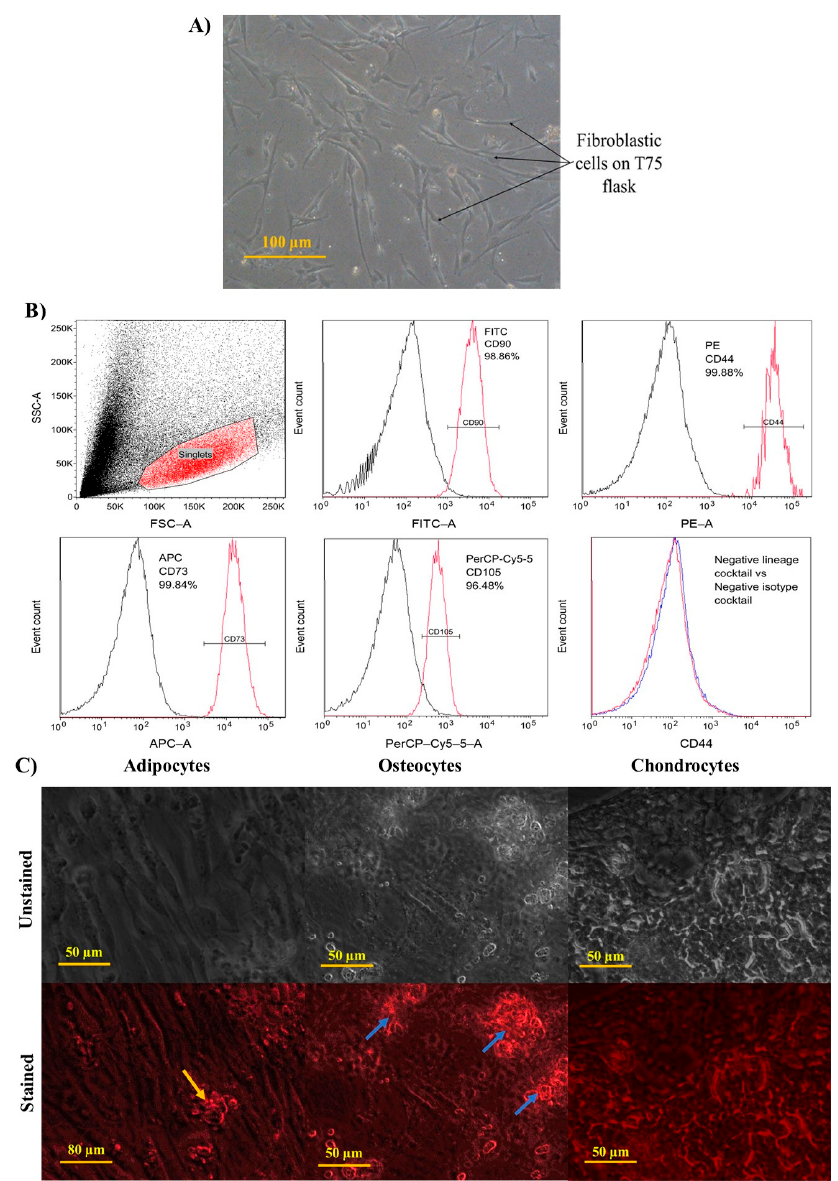
Figure 11. Characterisation of WJMSCs. ( A ) Morphology of WJMSCs showed fibroblastic characteris- tics. ( B ) Immnunophenotyping of WJMSC. The isolated WJMSCs displayed positive CD90, CD44, CD105, and CD73 expressions (red line). Each marker’s isotype is displayed by a black line. The negative lineage cocktail (red line) against the negative isotype cocktail (black line) showed negative expression of PE fluorescent. ( C ) Differentiation analysis of WJMSCs. Adipocytes, osteocytes, and chondrocytes are depicted in the figure as both unstained and stained cells. The developed cells are indicated by red fluorescence. The lipid droplet is indicated by a orange arrow. Calcium deposits are indicated by blue arrows. The image was taken under a 40 × objective